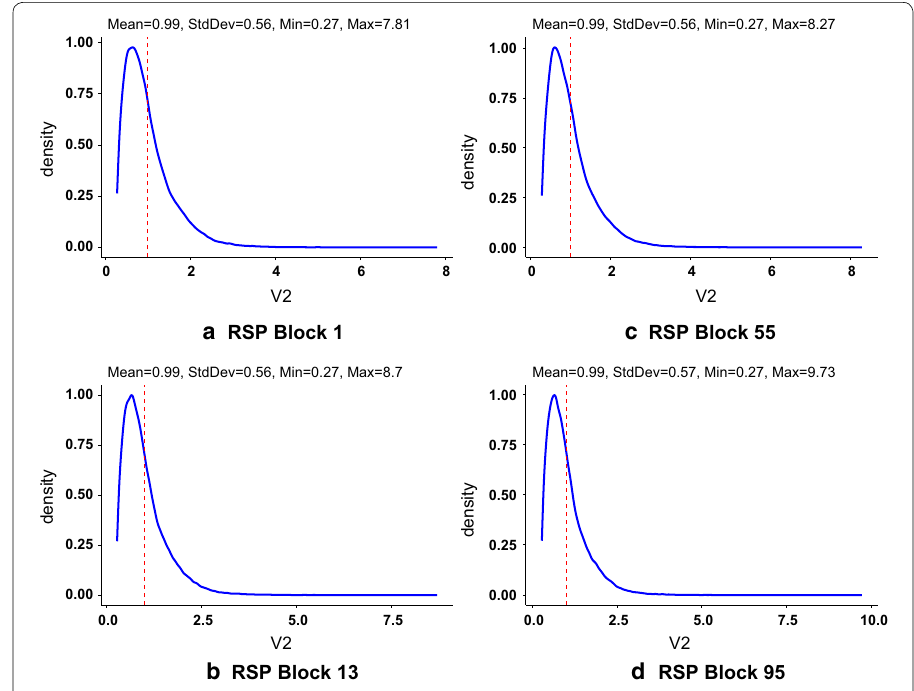
Fig. 4 Exploring the data distribution in HIGGS. Density plots of V2 in 4 RSP blocks from HIGGS